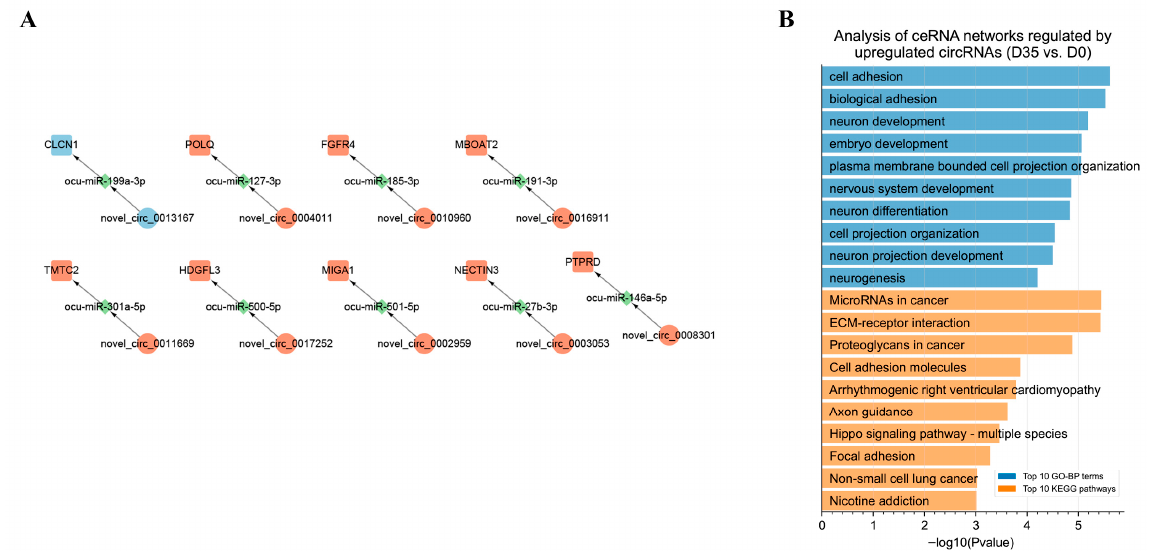
Figure 7. Functional annotation of circRNAs in putative DEC–DEmiRNA–DEmRNA networks from D0 to D35. ( A ) From D0 to D35, the circRNAs regulate host genes by interacting with miRNAs. The red and blue nodes indicate the upregulated and downregulated genes, respectively. ( B ) GO enrichment and KEGG pathway analysis of upregulated mRNAs in DEC–DEmiRNA–DEmRNA network from D0 to D35.